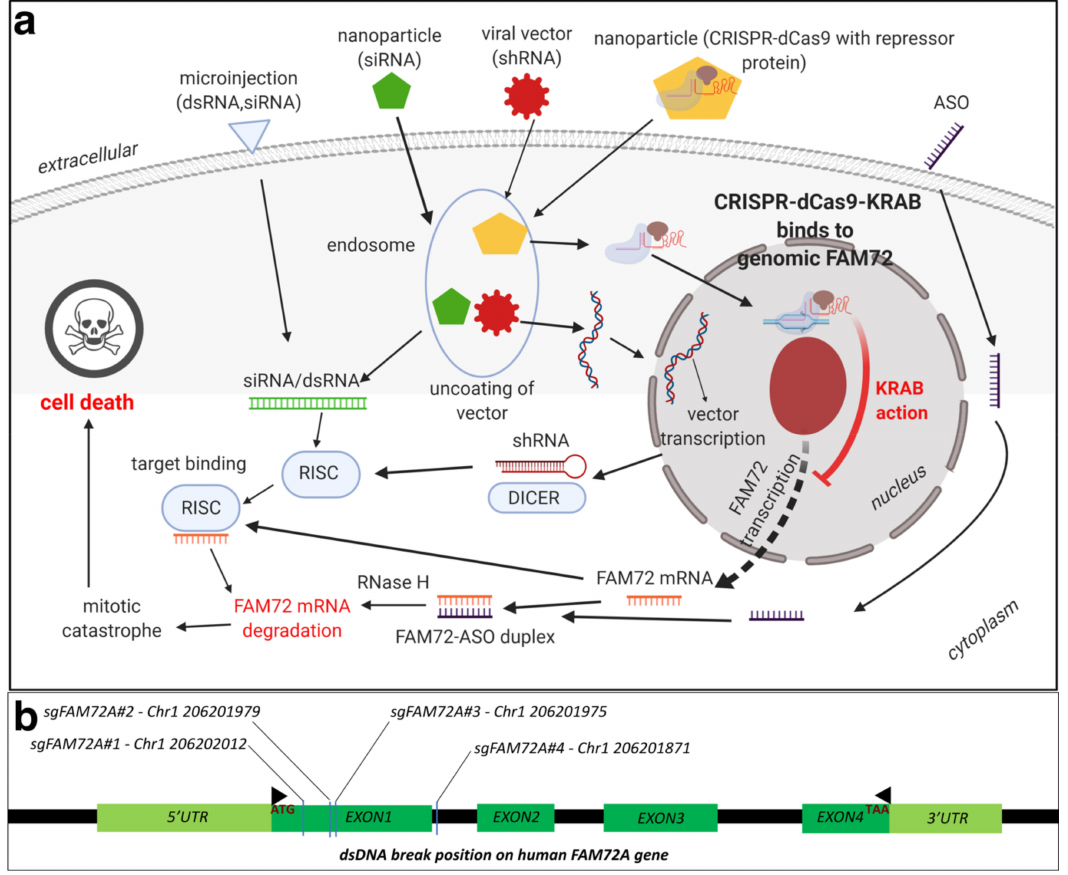
Figure 10. ( a ) Mechanisms of FAM72 knockdown using RNAi and CRISPR for the possible treatment of various types of cancer. Exogenous double-stranded RNA (dsRNA) or siRNA can be delivered via microinjection or lipid nanoparticles. The dsRNA or siRNA is released from the endosome after which it binds to the RNA-induced silencing complex (RISC). This complex then binds to the FAM72 mRNA, leading to the degradation of the whole complex. If shRNA is delivered via plasmid or viral vectors, the RNA is processed in the nucleus and exported into the cytoplasm. The Dicer enzyme processes shRNA into siRNA and then binds it to the RISC, followed by loading onto the target mRNA, and the resulting complex is degraded as before. Alternatively, the CRISPR-dCas9 with a transcriptional repressor protein is delivered via lipid nanoparticles. After entering the endosome, the CRISPR-dCas9 complex is released and it enters the nucleus. The Cas9 nuclease is directed to the target DNA by its bound sgRNA. Following binding of the dCas9 complex with the FAM72 target DNA, the repressor will attach to the transcriptional start site of FAM72, thereby resulting in a knockdown of